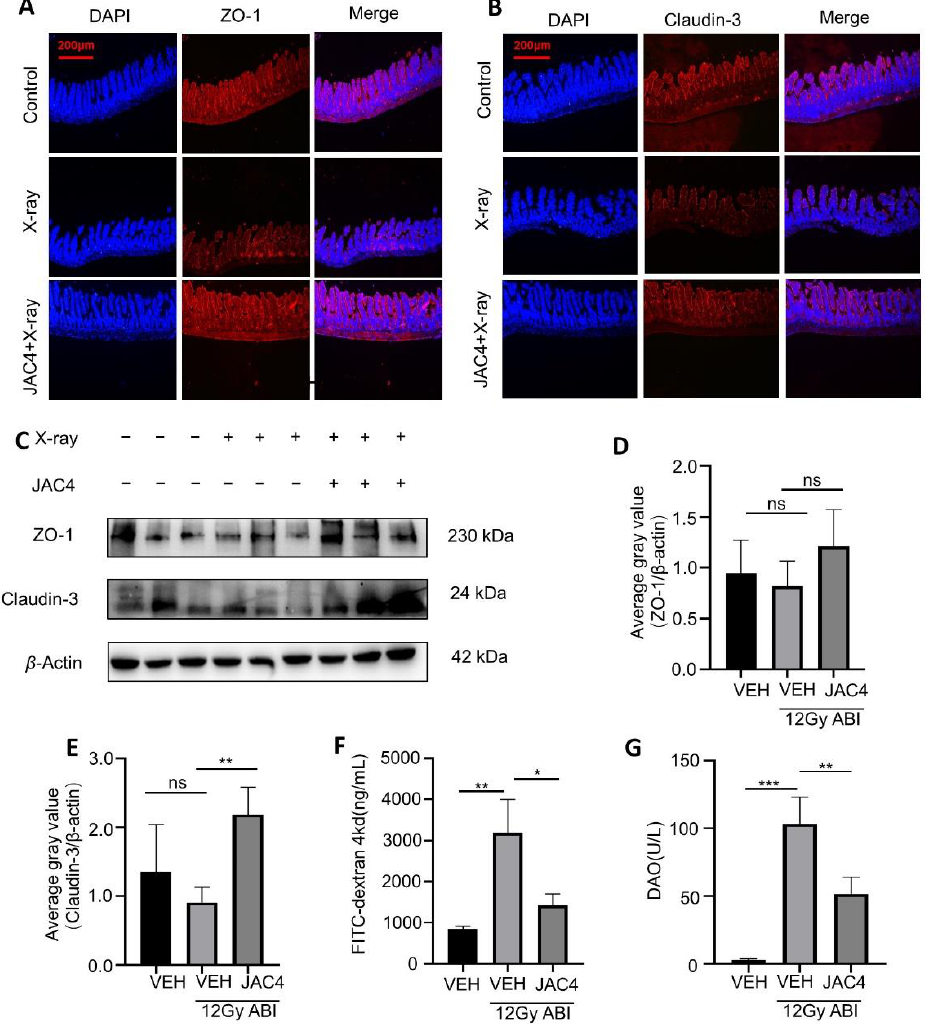
Figure 2. JAC4 treatment improved the intestinal mucosal barrier from radiation damage. ( A , B ) Represented images of immunofluorescence staining with Claudin-3 and ZO-1 antibodies in the jejunum on day 4 after ABI (n = 6). ( C – E ) Protein expression of Claudin-3 and ZO-1 in the jejunum on day 4 after ABI (n = 3). ( F ) The concentration of FITC-dextran in the plasma (n = 6). FITC-dextran was measured on day 4 after ABI. ( G ) DAO activity in the plasma. The results are expressed as mean ± SEM (* p < 0.05; ** p < 0.01; *** p < 0.001; ns: p > 0.05).